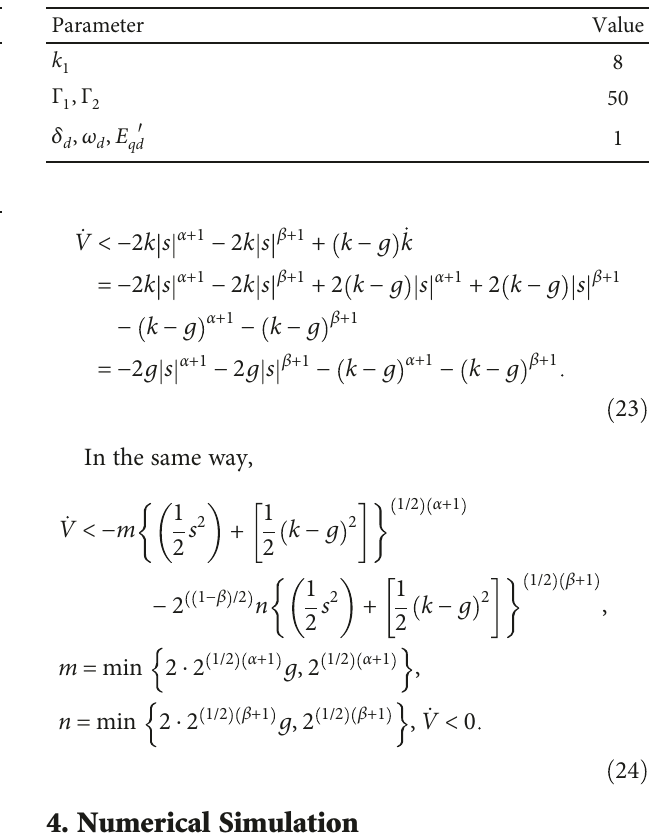
Table 1: System parameters. Table 2: Control